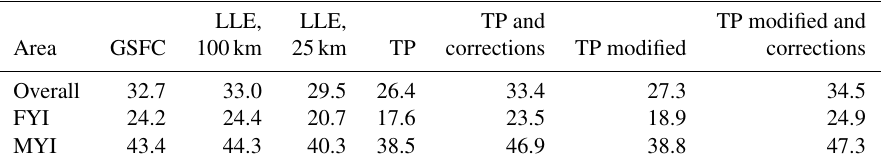
Table 4. Mean freeboard as derived from the GSFC product and estimated in this study using different methods, along-track averaging scales and with or without applied corrections for snow depth in leads and lead width. LLE, LLE, TP